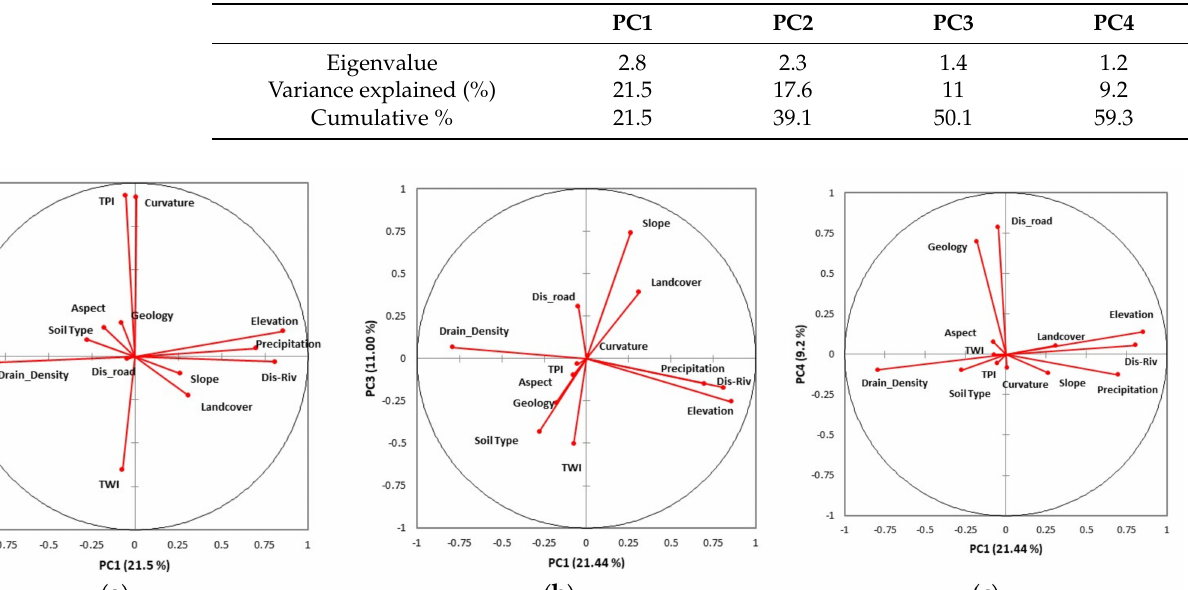
Table 2. Eigenvalues and percentage of variance explained by the first four principal components.